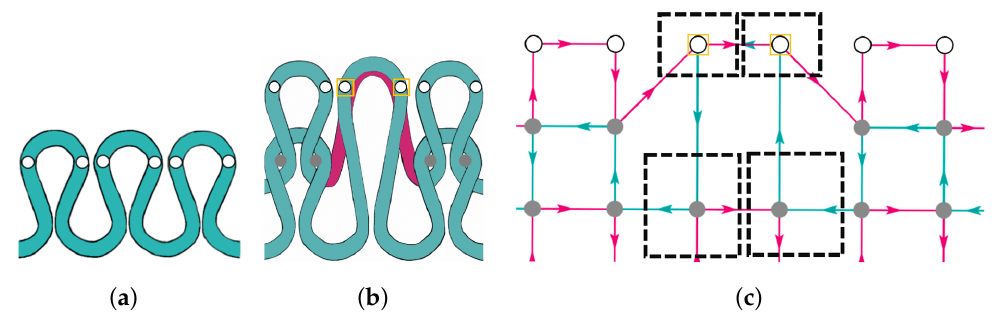
Figure 6. A Front Tuck stitch is created by tucking a yarn onto a loop held by a needle on the front bed from the previous row, instead of creating a new stitch. ( a ) Row of loops. ( b ) Two Knit stitches and a Front Tuck stitch produced from another row of stitches. ( c ) Topological